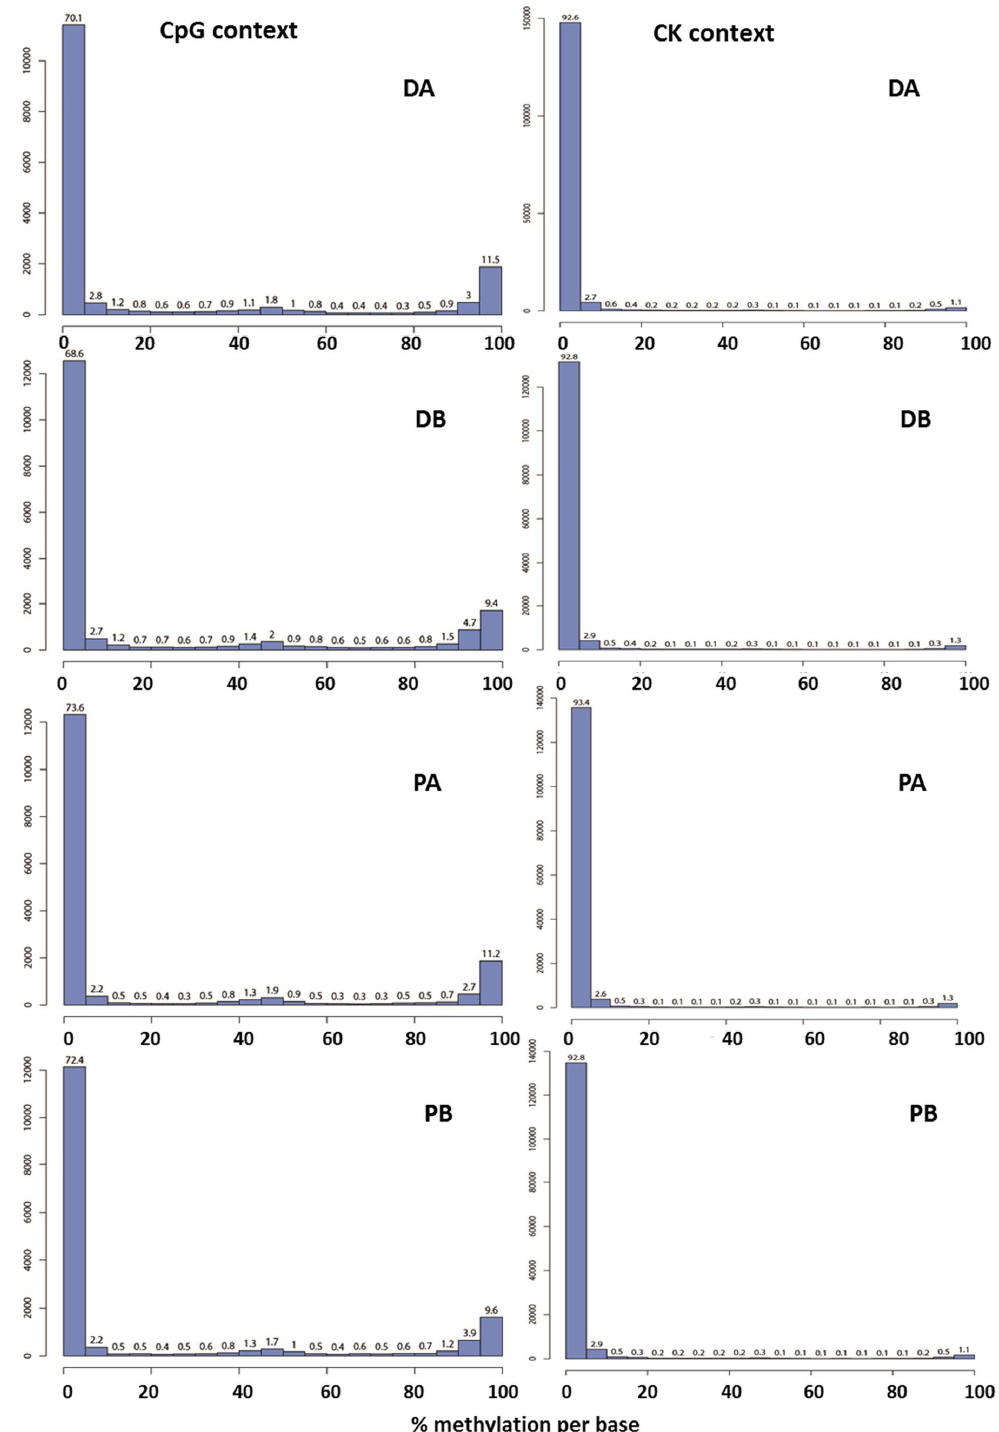
Figure 2. Percentage of DNA methylation of the samples tested in the CpG and CK (including CHG and CHH) contexts during the 2015–2016 season. “D” = ‘Desmayo Largueta’, “P” = ‘Penta’, “A” = dormant bud stage, “B” = non-dormant bud stage.